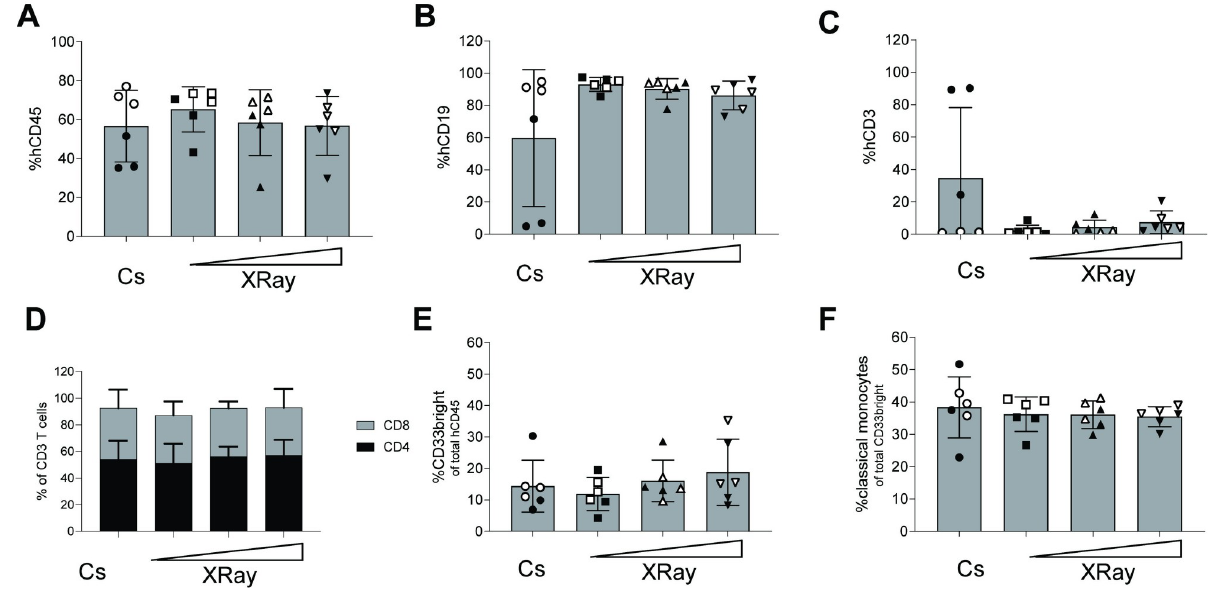
Fig 3. Bone marrow in NOG mice humanized following either irradiation from a Cs source or an X-ray device. (A) Bar graph for each irradiation group showing the percentage of human cells, based on expression of hCD45 out of total WBCs identified in a forward/side-scatter flow cytometry gating plot. (B) Bar graph of the frequencies of human B cells based on expression of surface hCD19. (C) Bar graph of the frequencies of human T cells based on expression of surface hCD3. (D) Bar graphs of frequencies of human T cell subsets based upon expression of surface CD4 or CD8 presented in (C). (E) Bar graphs presenting myeloid cells based on expression of CD33 out of total hCD45. (F) Classical monocytes based on expression of CD14 and lack of CD16-expression (CD14+CD16neg) within the myeloid cells population in (E). Each dot represents one mouse (6 mice per group) presented with mean ± S.D.The horizontal triangle ( ◿ ) illustrates increasing doses of X-ray-derived radiation. Stem cell Donor A-derived mice are full circles ( ● ) and Donor B-mice empty circles ( � ).